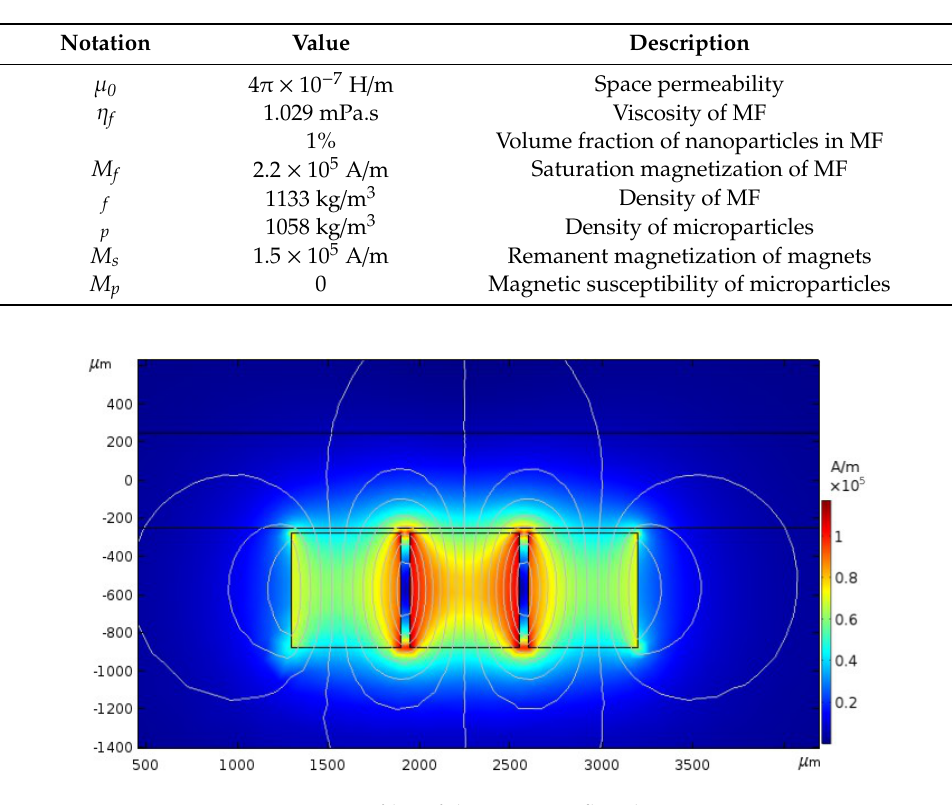
Figure 3. Profiles of the magnetic flux density.